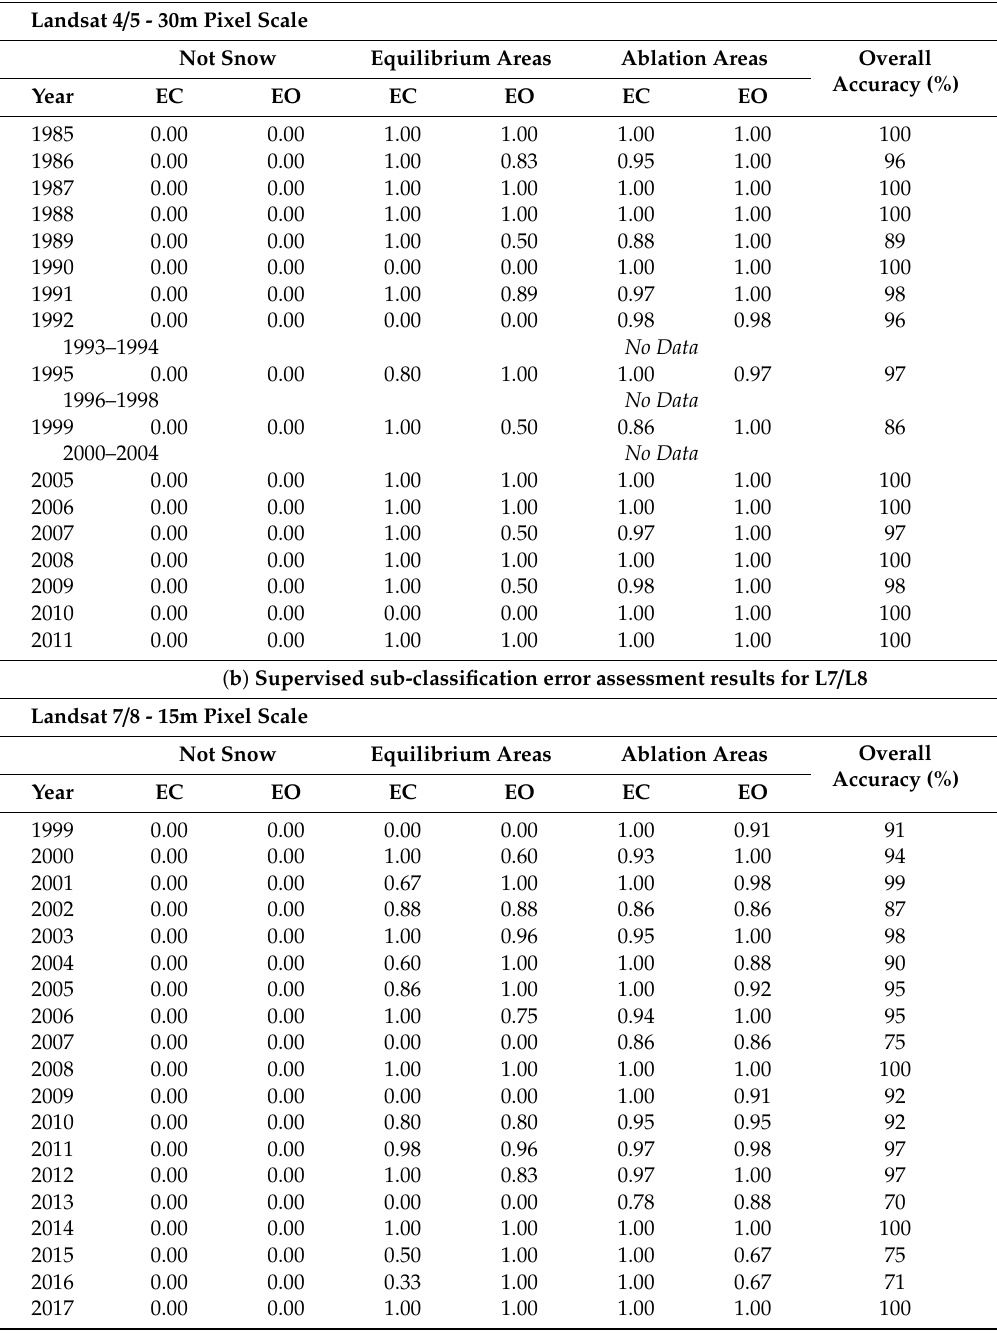
Table 1. Supervised sub-classification error assessment results. (a) Supervised sub-classification error assessment results for L4 /